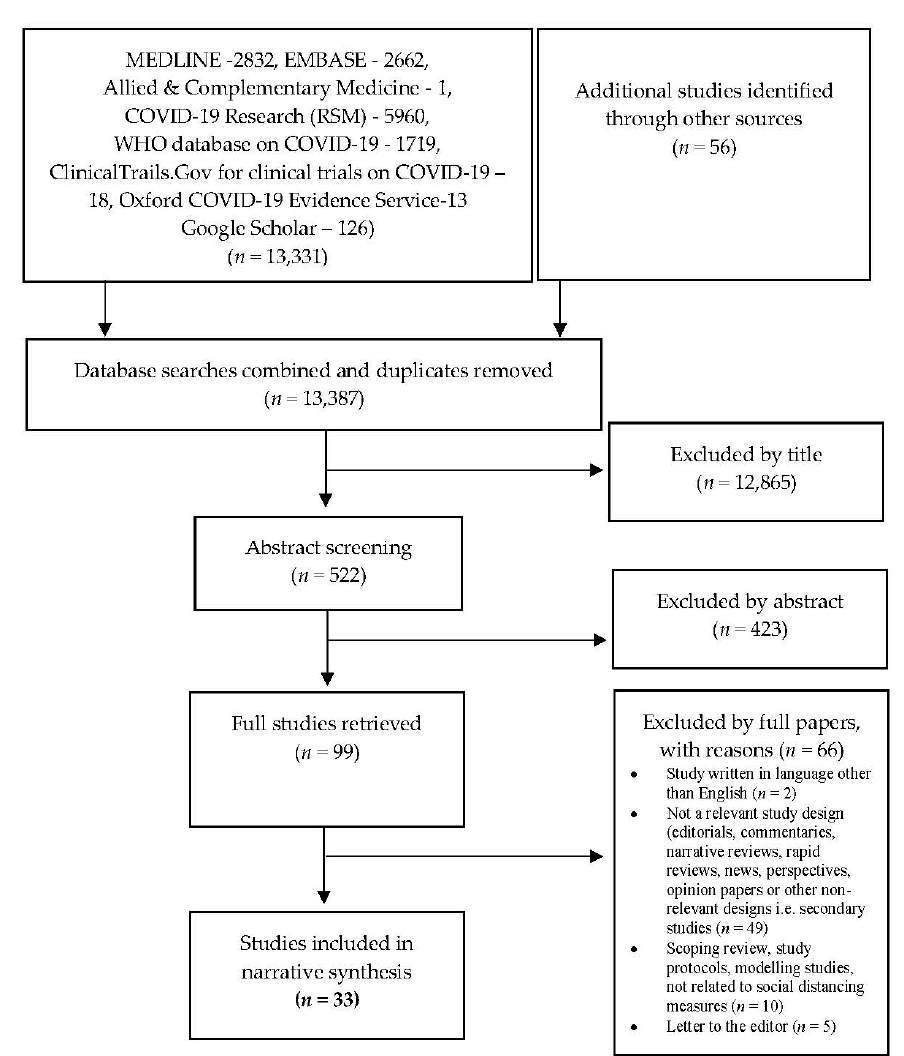
Figure 1. PRISMA flow diagram to show results of searches.